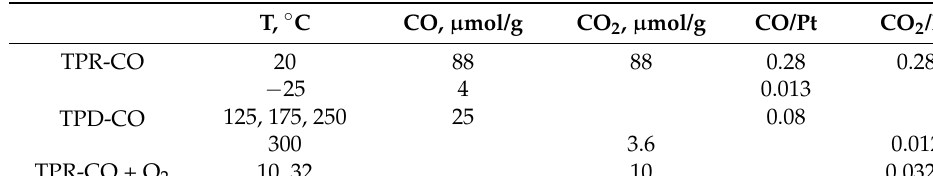
Table A2. TPR-CO, TPD-CO, and TPR-CO + O 2 data.